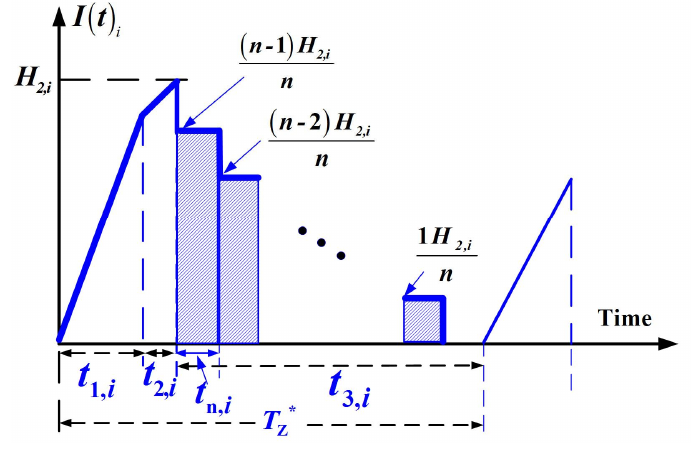
Fig. 4. Each end product i ’s inventory status during t 3, i